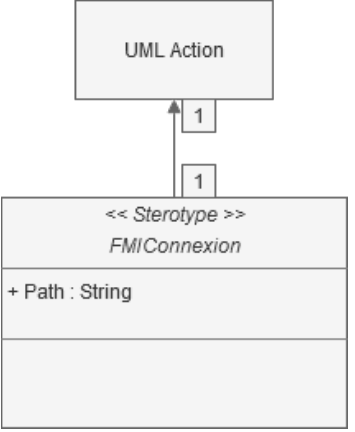
Figure 6. Functional mockup interface (FMI) Papyrus profile.